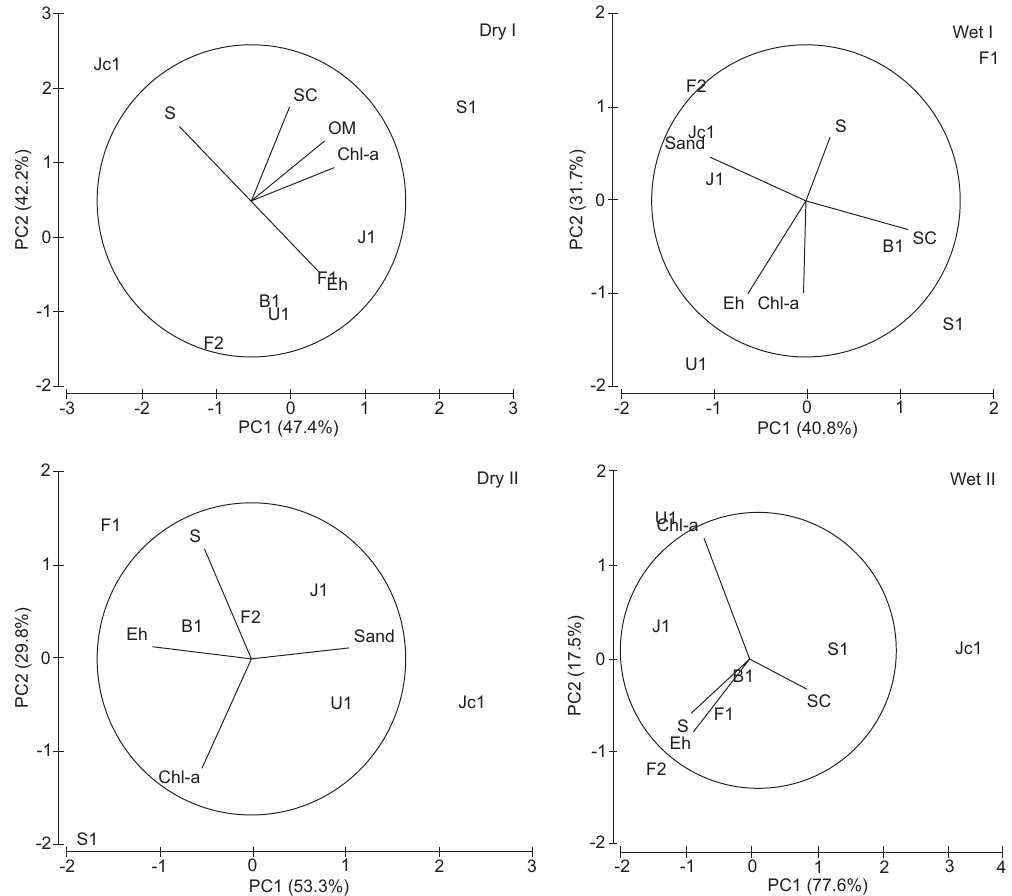
Figure 2. Factorial axis 1 and 2 of Principle Components Analysis (PCAs) ordinations for environmental variables per sampling period in Saquarema-Jaconé lagoonal system. (S) Salinity, (Eh) redox potential, (OM) organic matter, (Chl-a) chlorophyll-a, (SC) sorting